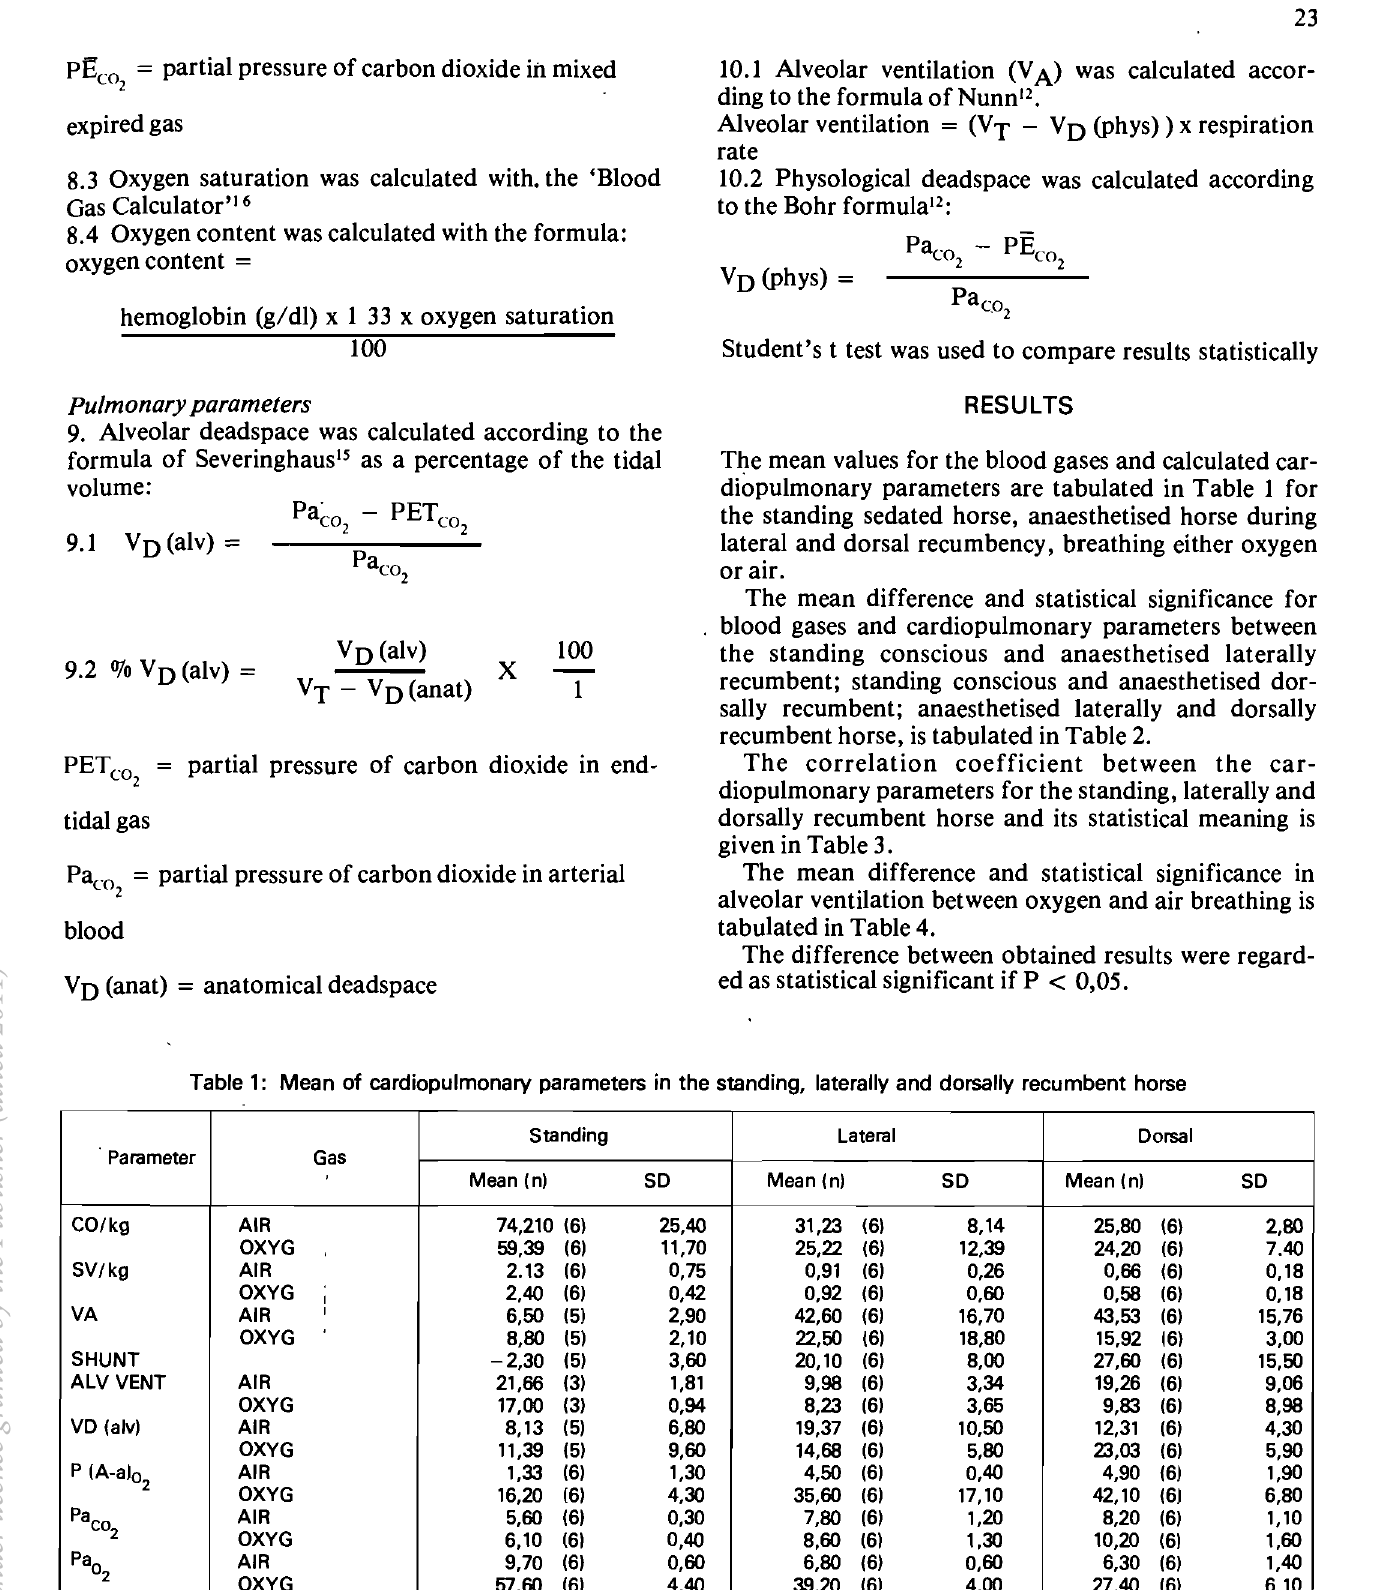
Table 1: Mean of cardiopulmonary parameters in the standing, laterally and dorsally recumbent horse